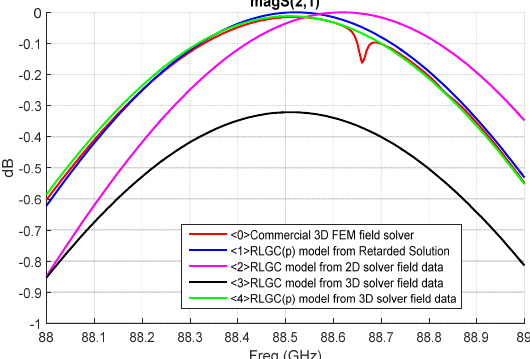
Figure 18: Magnitude of S12 from 88 GHz to 89